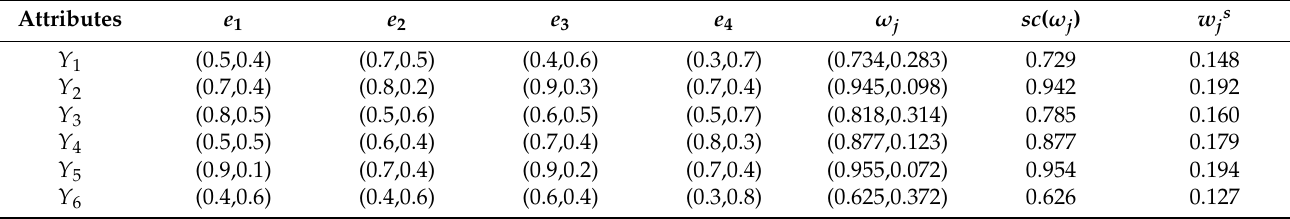
Figure 2. The calculation process of PyF-ITARA. Table 6. The subjective weights of